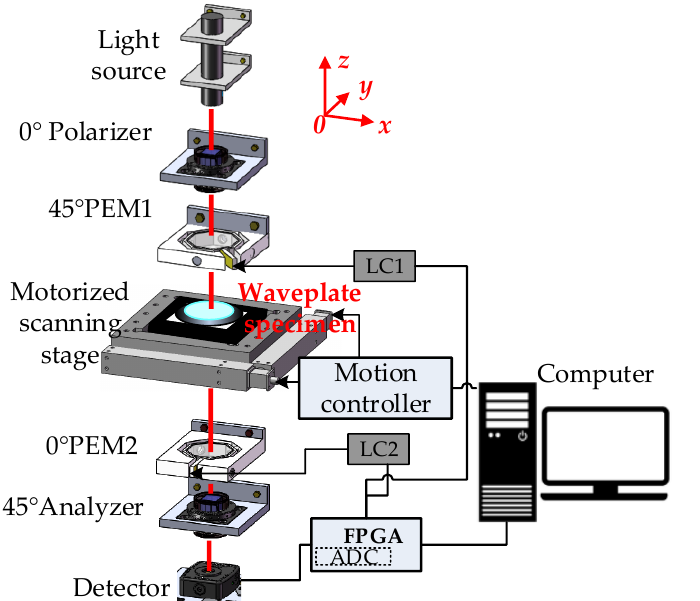
Figure 1. Schematic diagram of waveplate parameter measurement. FPGA: field programmable gate array; LC: inductance – capacitance resonant driving circuit; ADC: analog-to-digital converter.